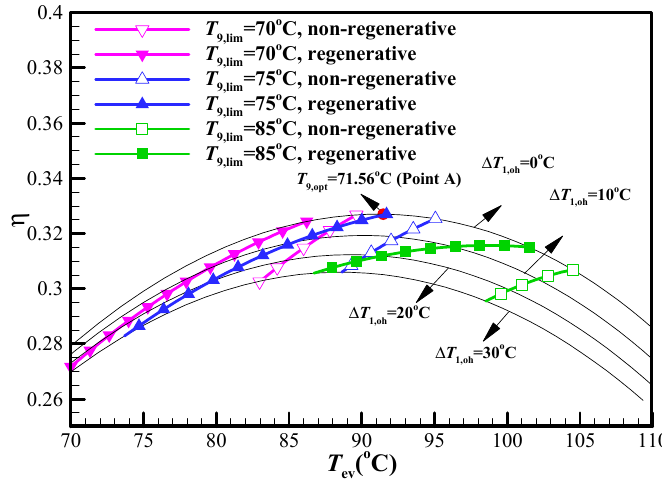
Figure 8. Plant exergy efficiency profiles with various reinjection temperature limits using R245fa.